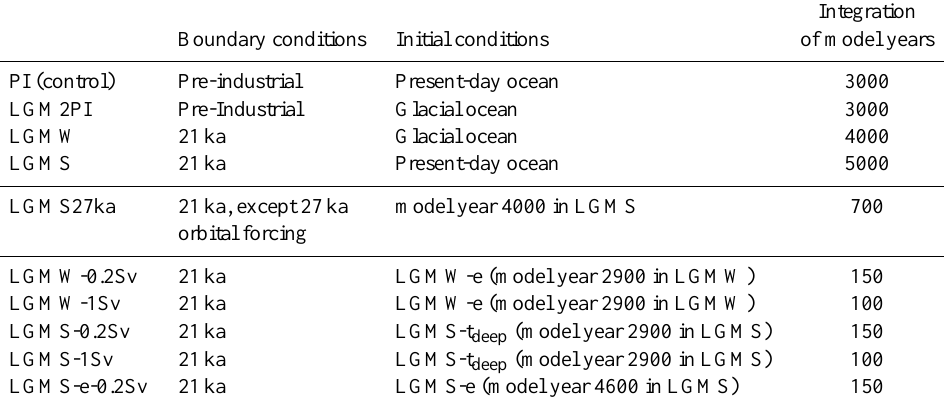
Table 1. Experimental design of the simulations in this study. Integration Boundary conditions Initial conditions of model years PI (control) Pre-industrial Present-day ocean 3000 LGM2PI Pre-Industrial Glacial ocean 3000 LGMW 21ka Glacial ocean 4000 LGMS 21ka Present-day ocean